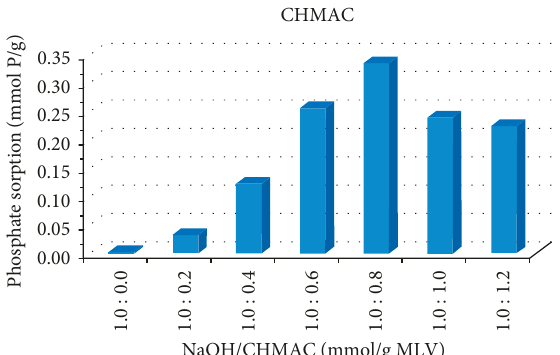
Figure 4: Phosphate sorption (expressed as P) by CALV biosorbent in function of the NaOH/CHMAC ratio (1.0:0.0 to 1.0:1.2